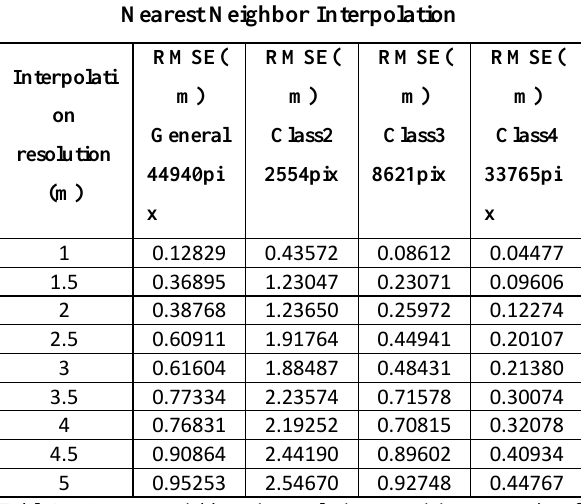
Table3. Nearest neighbor interpolation precision at each of classes with increasing step of a pixel